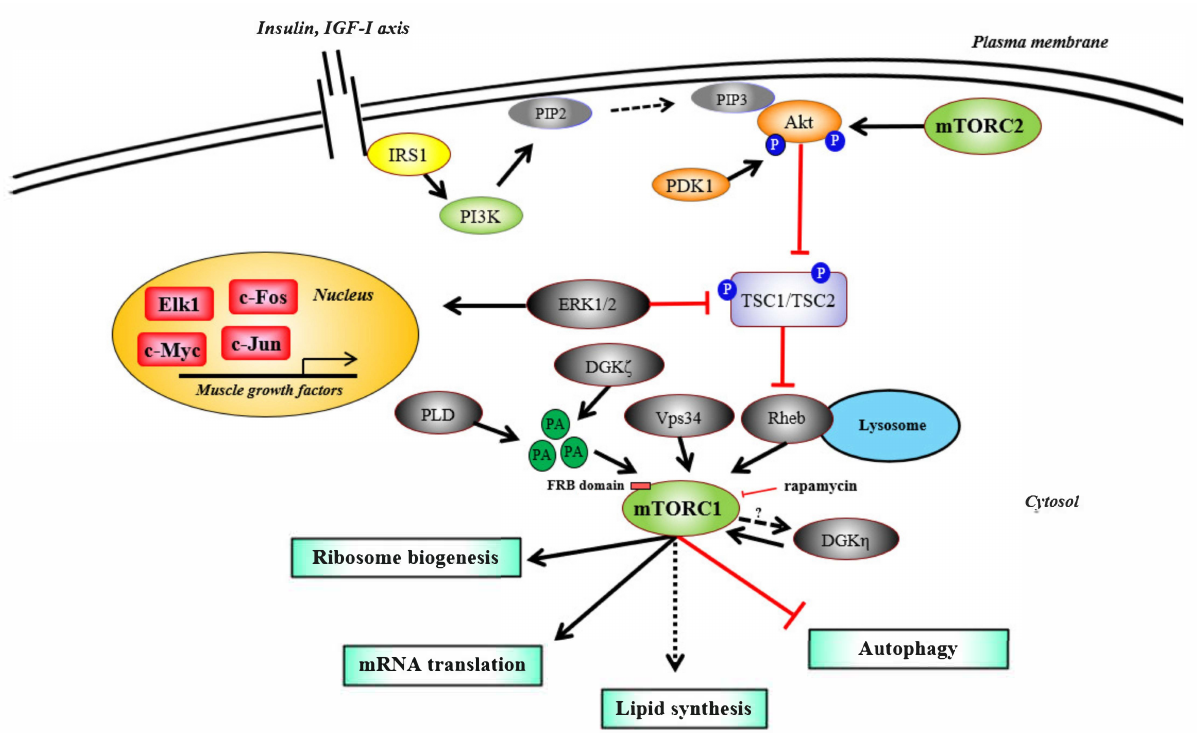
Figure 1. mTORC1 regulates skeletal muscle protein synthesis. Upon IGF-1 (insulin-like growth factor 1) axis activation, IRS1 (insulin receptor substrate 1) activates the lipid kinase PI3K (phosphoinositide 3-kinase). PI3K phosphorylates the membrane- bound phospholipid PIP2 (phosphatidylinositol diphosphate) and generates PIP3 (phosphatidylinositol triphosphate), which recruits Akt/PKB (protein kinase B) and PDK1 (phosphoinositide-dependent kinase-1). PDK1 phosphorylates and activates Akt, which then phosphorylates and inactivates TSC1/TSC2 (tuberous sclerosis complex 1/2), a RHEB (Ras homolog enriched in brain) inhibitor. RHEB then activates mTOR (mechanistic/mammalian target of rapamycin). In response to mechanical stimuli, mTOR is also activated by branched-chain amino acids, Vps34 (vacuolar protein sorting 34), DGK η (diacylglycerol kinase eta) and by PA (phosphatidic acid). PA is synthesized by PLD (phospholipase D) and DGK ζ (diacylglycerol kinase zeta) and targets mTOR on its FRB (FKBP-rapamycin-binding) domain to induce its activation. Amino acids promote the recruitment of mTOR to the lysosomal surface, where mTOR is activated by RHEB. ERK1/2 (extracellular signal-regulated kinase 1/2) inhibits TSC1/TSC2 and promotes the transcription of genes involved in muscle growth through Elk1 (ETS-like protein-1), c-Fos, c-Jun and c-Myc. mTOR in association with RICTOR (rapamycin-insensitive companion of mTOR) forms mTORC2 (mechanistic/mammalian target of rapamycin complex 2) and fully activates Akt. mTORC1 (mechanistic/mammalian target of rapamycin complex 1) plays critical roles in mRNA translation, ribosome biogenesis, autophagy inhibition, and perhaps in lipid synthesis in muscle